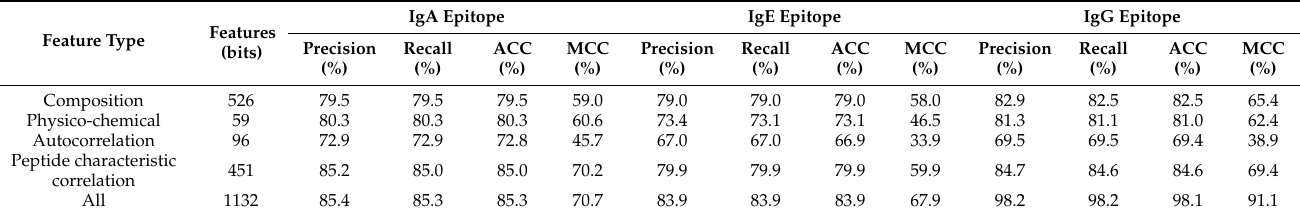
Table 3. Comparison of performances using various features.